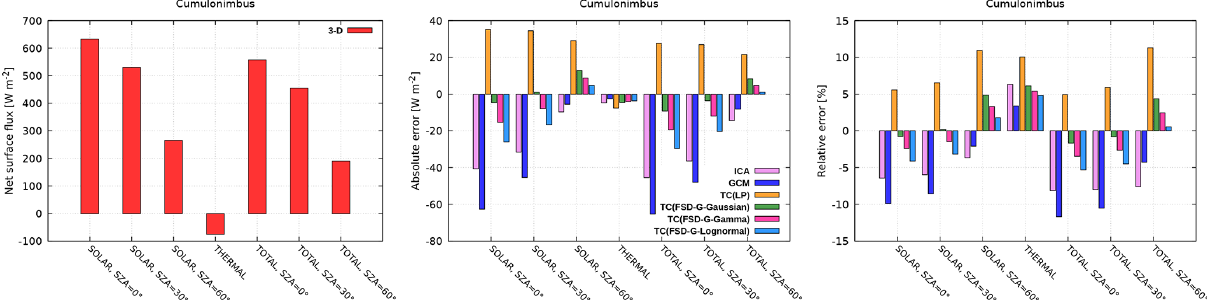
Figure 12. Net surface radiative flux for